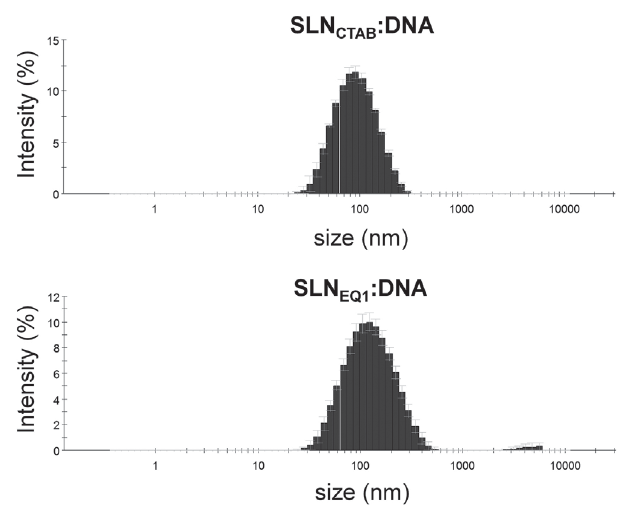
FIGURE 3 - Intensity-size distribution graphs of SLN:DNA complexes.